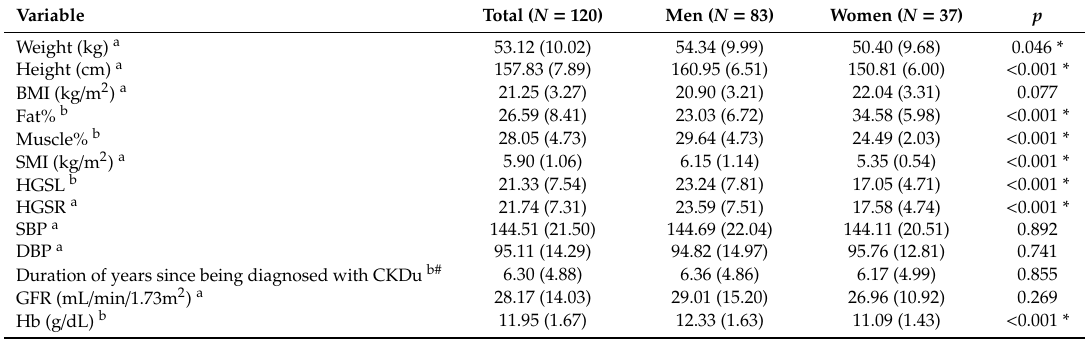
Table 1. Anthropometric and disease-related characteristics by